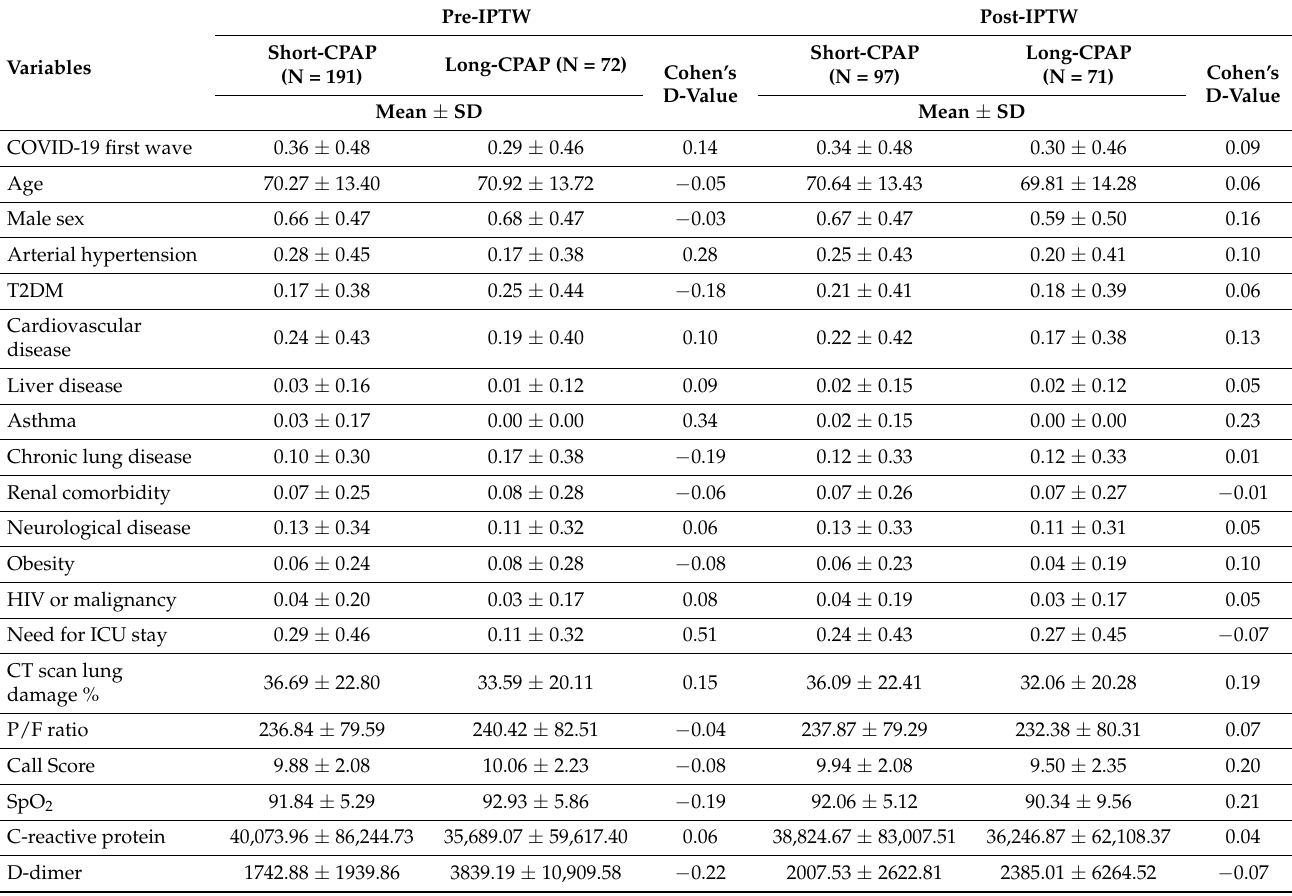
Table 2. Effect of stabilized IPTW in the population on the variables used to balance the two